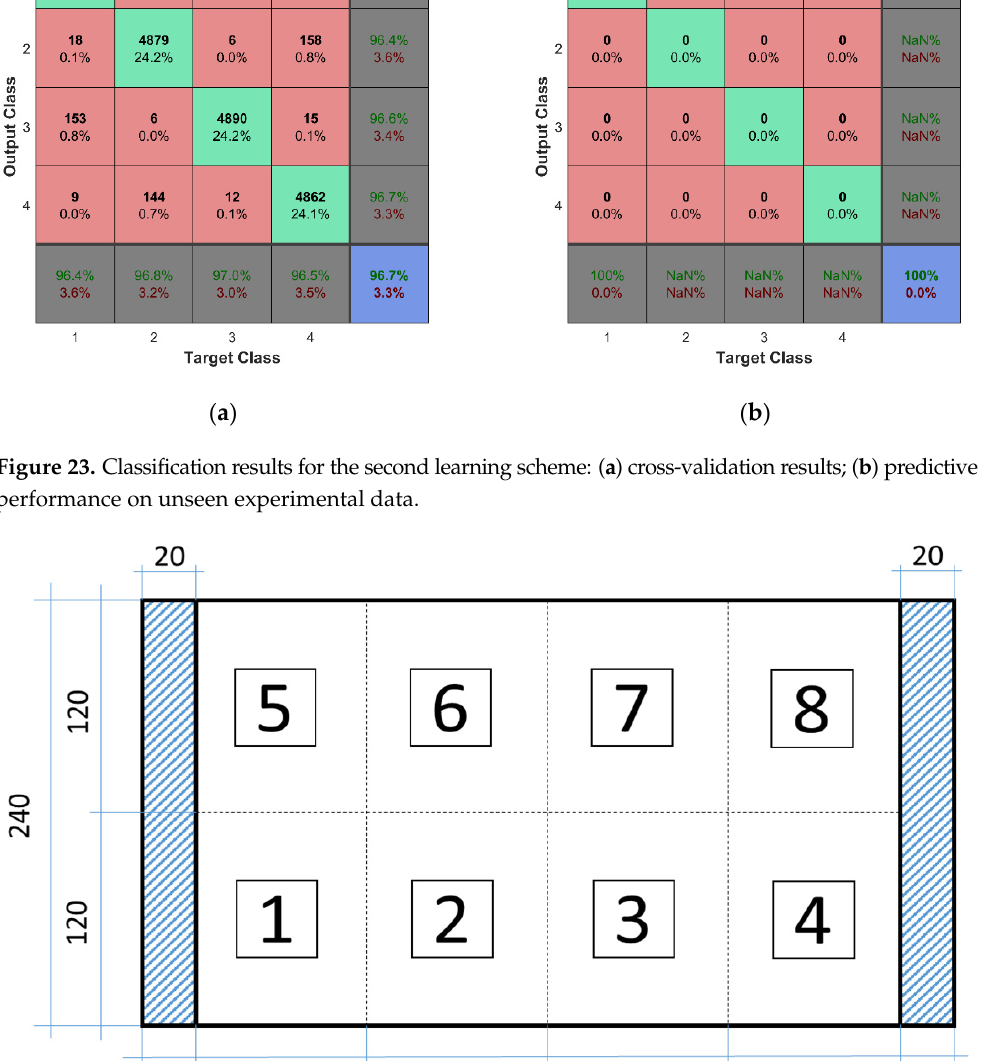
Figure 23. Classification results for the second learning scheme: ( a ) cross-validation results; ( b ) pre- dictive performance on unseen experimental data.